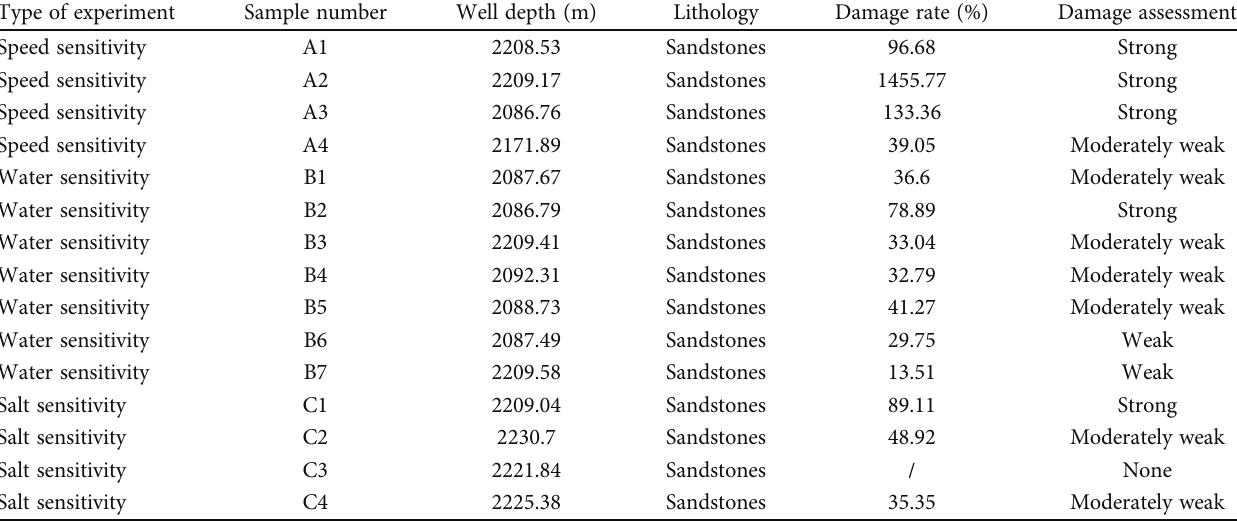
Table 3: Experimental results of velocity sensitivity, water sensitivity and salt sensitivity in the Weizhou 11-4N oil fi eld. Type of experiment